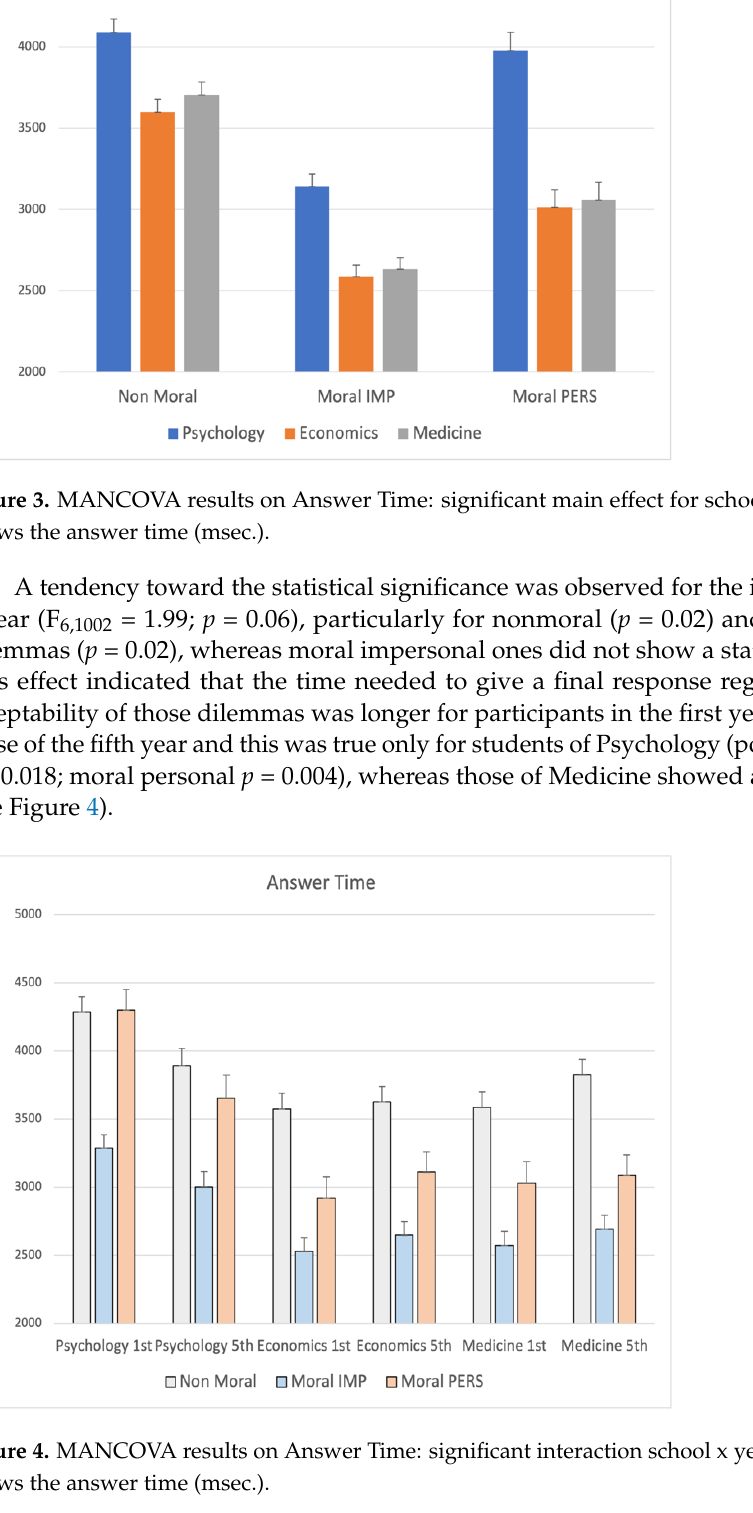
Figure 4. MANCOVA results on Answer Time: significant interaction school x year. Note: the y-axis shows the answer time (msec.). shows the answer time